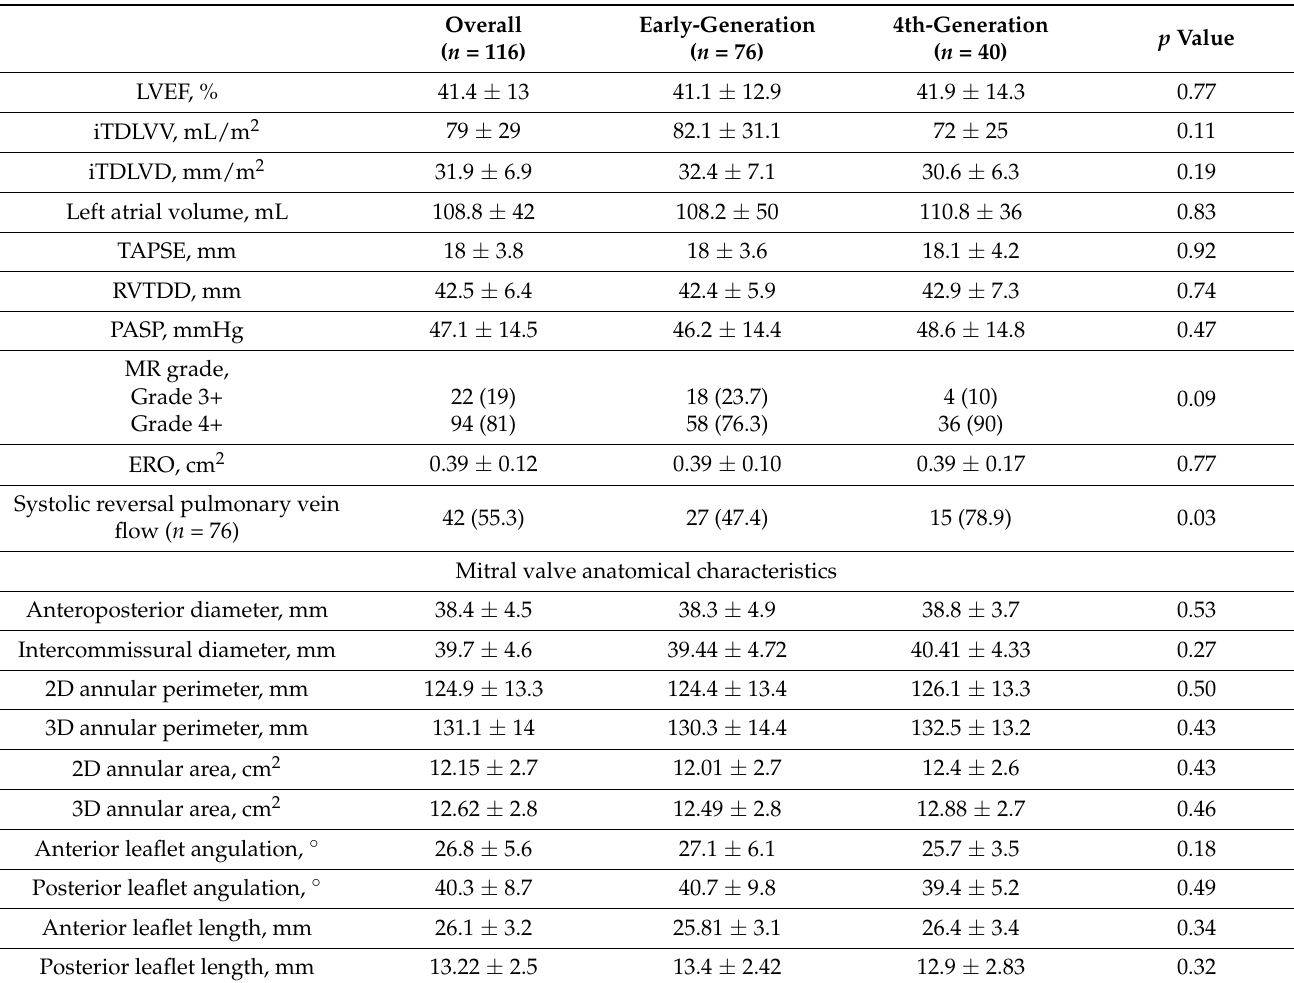
Table 2. Baseline echocardiographic